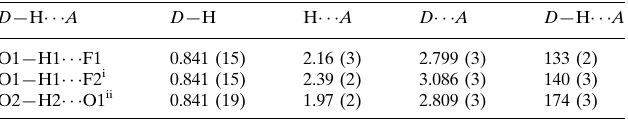
Hydrogen-bond geometry (A˚ , (cid:2)